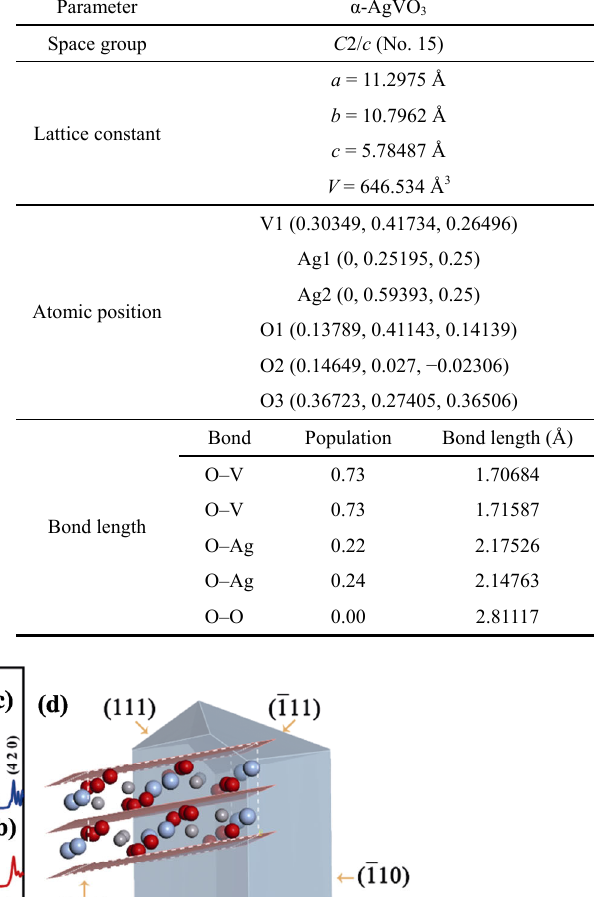
Table 1 Geometry optimized lattice constants, atomic